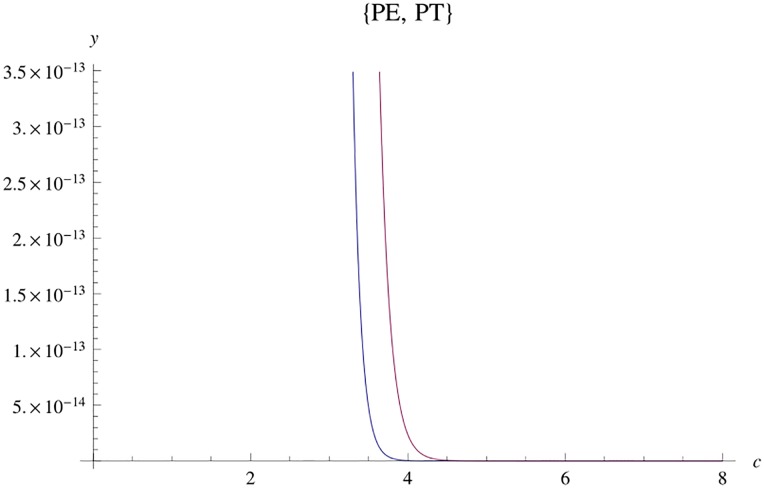
Graphs of PE and PT for nT = nR = l = 3.